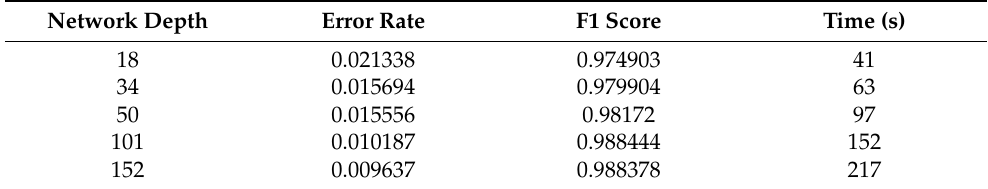
Table 7. Network depth on validation split = 40.